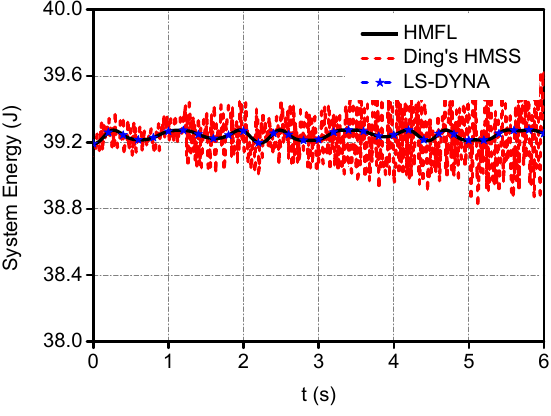
Figure 5. Total energy of the rubber conical pendulum system.